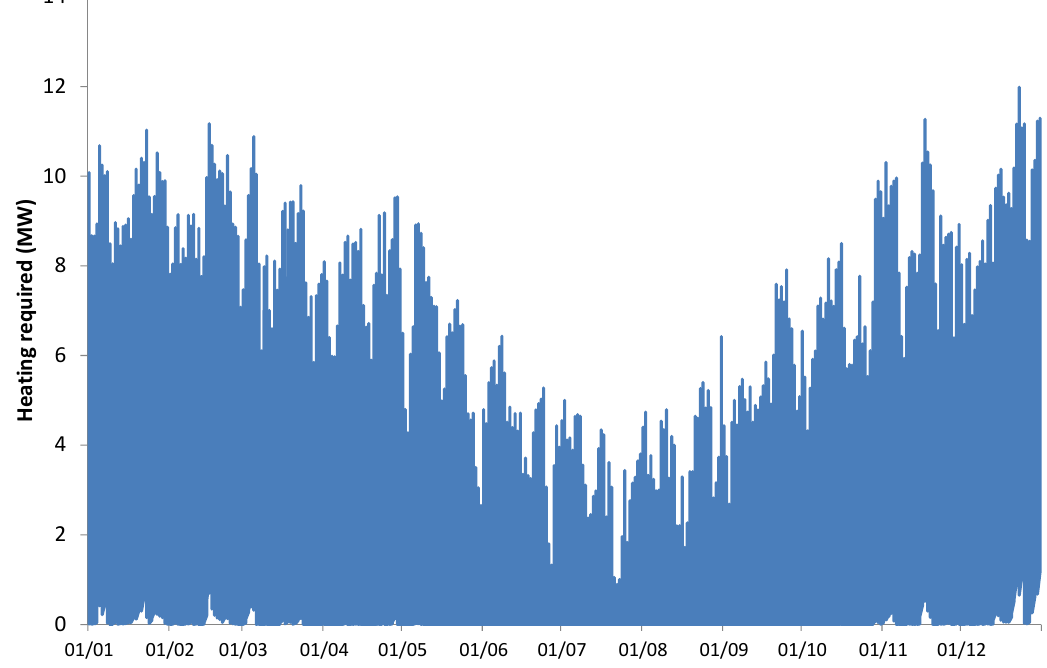
Figure 6. Example of an hourly aggregated thermal demand profile of 1271 dwellings as simulated using described